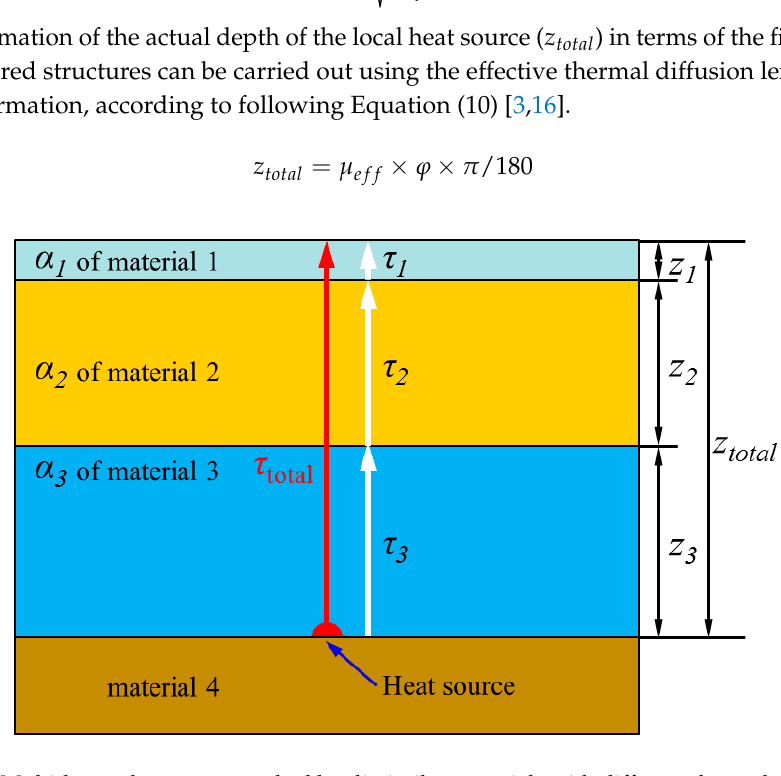
Figure 4. Multi-layered structure stacked by dissimilar materials with different thermal diffusivity.